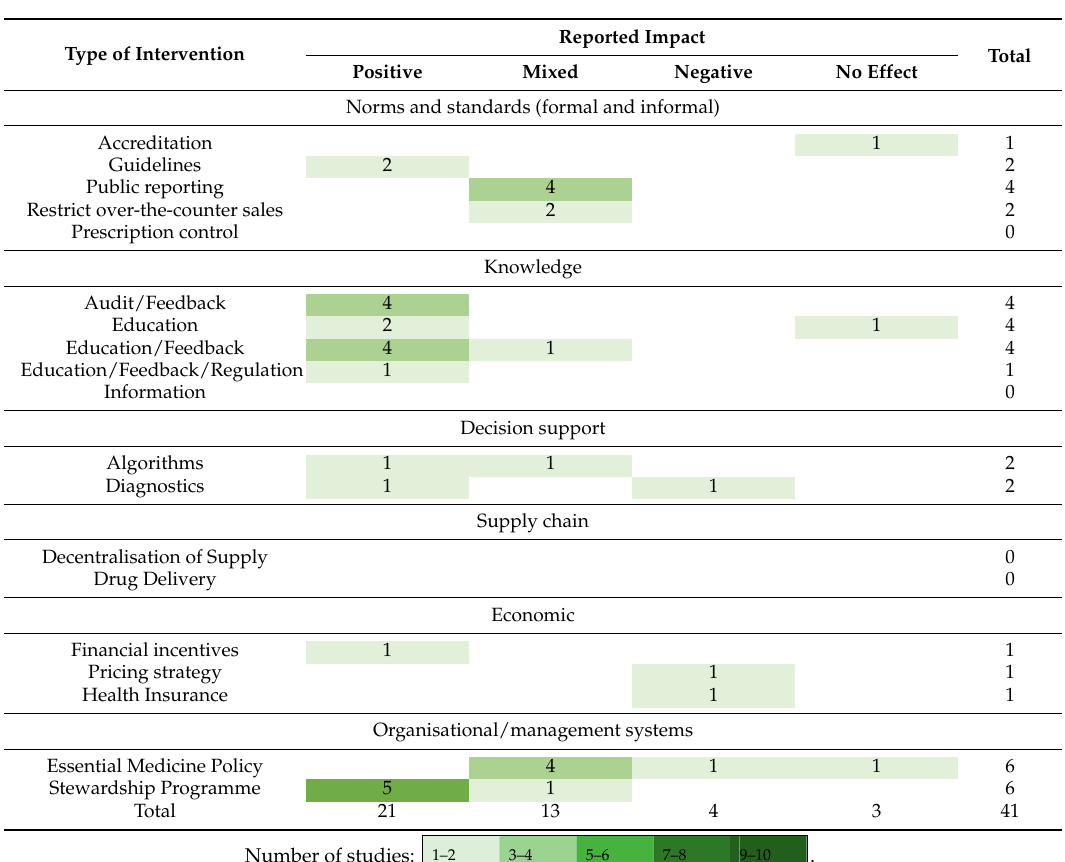
Table 5. Summary of intervention impacts.